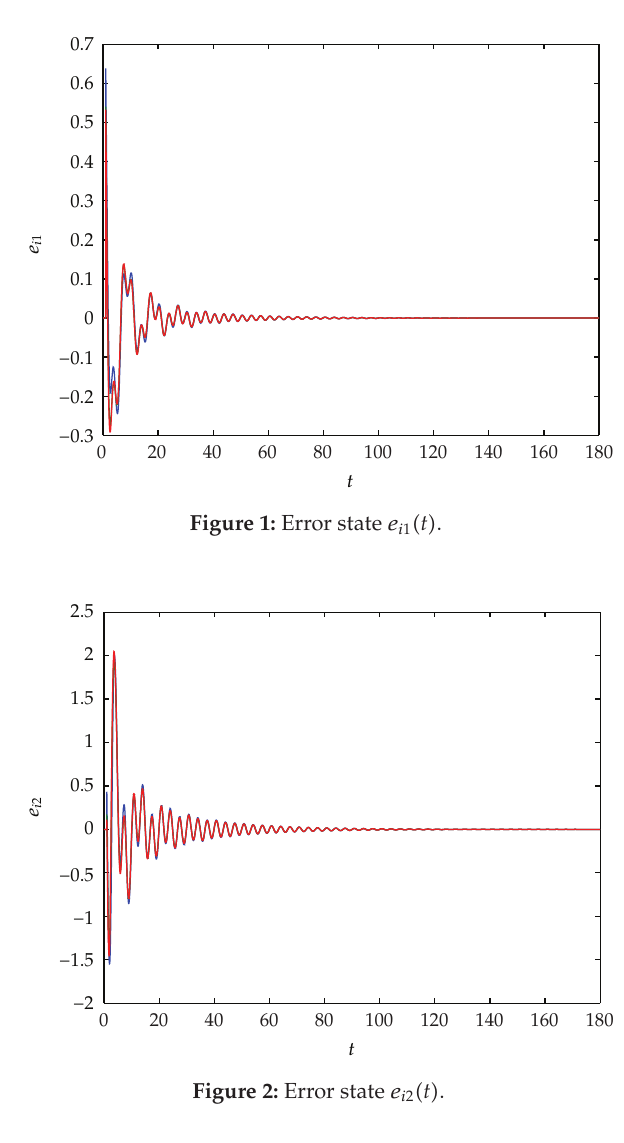
Figure 2: Error state e i 2 (cid:6) t (cid:7)